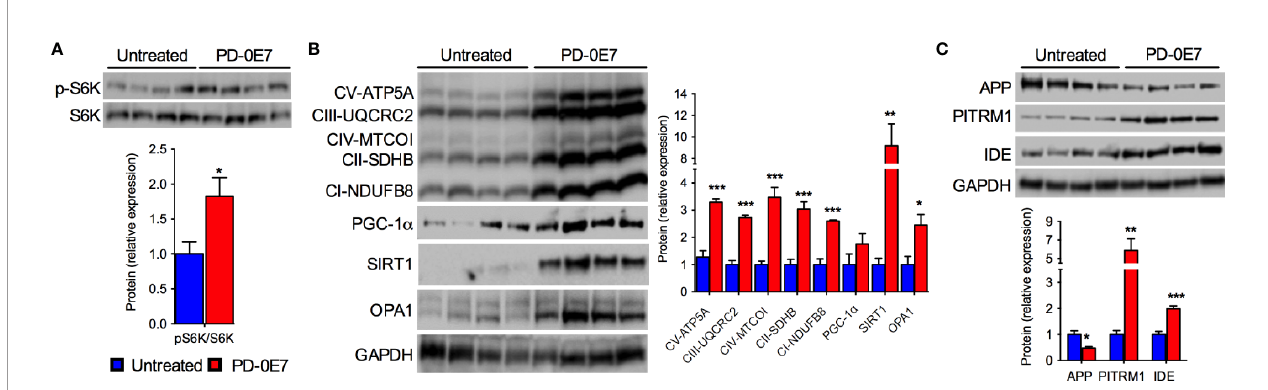
FIGURE 6 | Effects of PD-0E7 on mitochondrial function in the hippocampus of aged SAMP8 mice. (A) Western blot analysis of phosphorylated p70 S6 kinase 1 (p- S6K) and total S6K in hippocampal homogenates; quanti fi cation of pS6K/S6K ratio is shown below the image (blue bars, untreated mice, red bars, PD-0E7-treated mice). (B) Western blot analysis of PGC-1 a , SIRT1, OPA1, and the mitochondrial respiratory chain (MRC) subunits ATP5A, UQCRC2, MTCOI, SDHB, NDUFB8 in mouse hippocampi; relative quanti fi cation of protein to GAPDH levels is shown on the right. (C) Western blot analysis of amyloid precursor protein (APP), pitrilysin metallopeptidase 1 (PITRM1), and insulin-degrading enzyme (IDE) protein levels and quanti fi cation relative to GAPDH levels. All color codes as in (A) . Statistical analysis was performed with unpaired Student ’ s t test. Error bars represent SEM, n=4 mice/group, *p < 0.05, **p < 0.01, ***p <